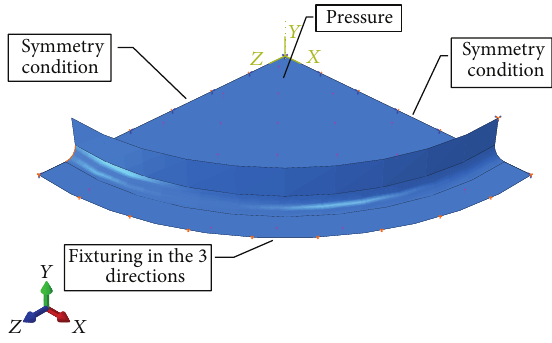
Figure 12: Boundary conditions of the models for MSC-MARC and